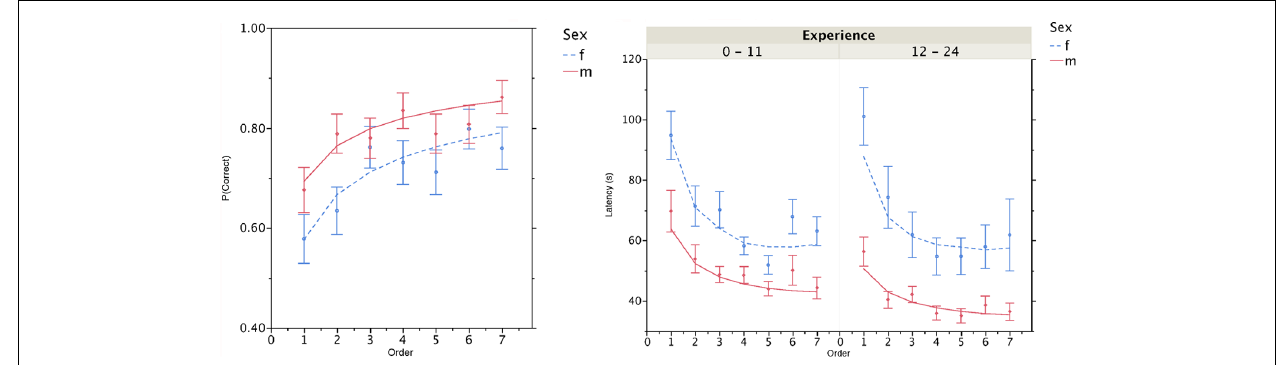
FIGURE 1 | (A) Increase in accuracy as a function of the order in which a decision was made, shown separately for men and women. (B) Decrease in latency as a function of decision order, shown separately for men and women and self-related experience playing